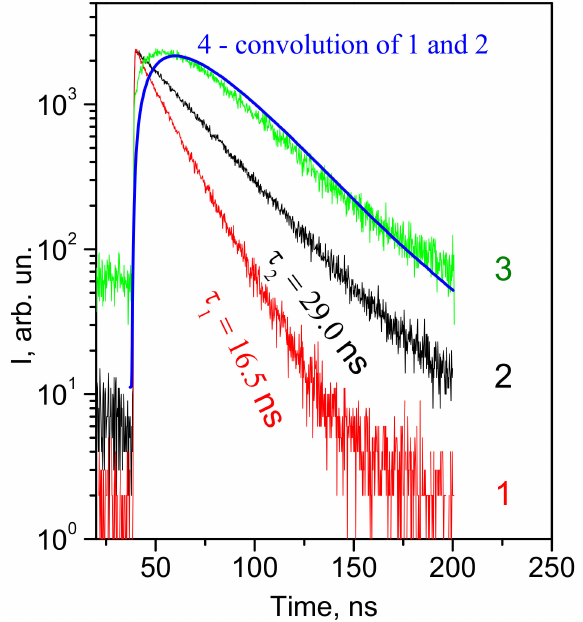
Figure 5. Kinetics of luminescence decay of 4f-5d cerium excitons ( λ em = 290 nm) for the excitation at λ exc = 220 nm (1), luminescence band at λ em = 340 nm for the excitation at λ exc = 270 nm (2) and λ exc = 220 nm (3). Convolution (curve 4) of 1 and 2 curves. T = 10